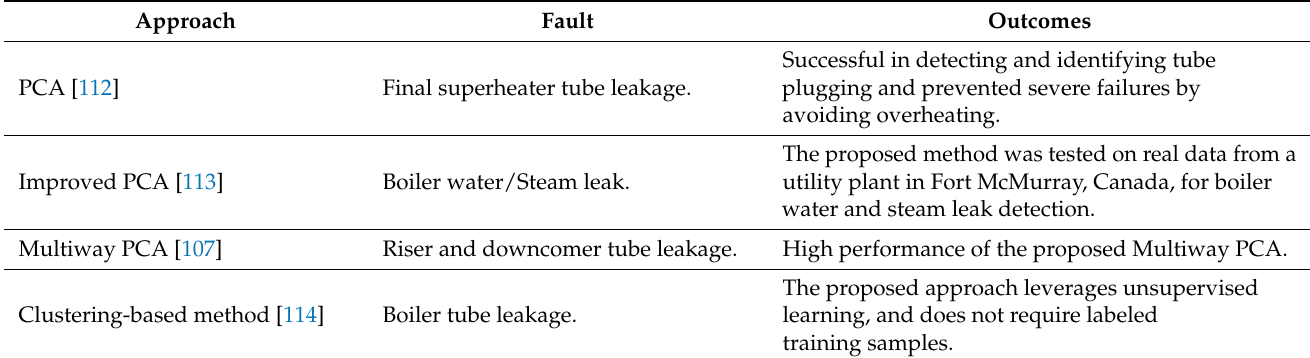
Table 6. Comparison of Different Statistical analysis-based Algorithms for Boiler Tube Leak Detec- tion.